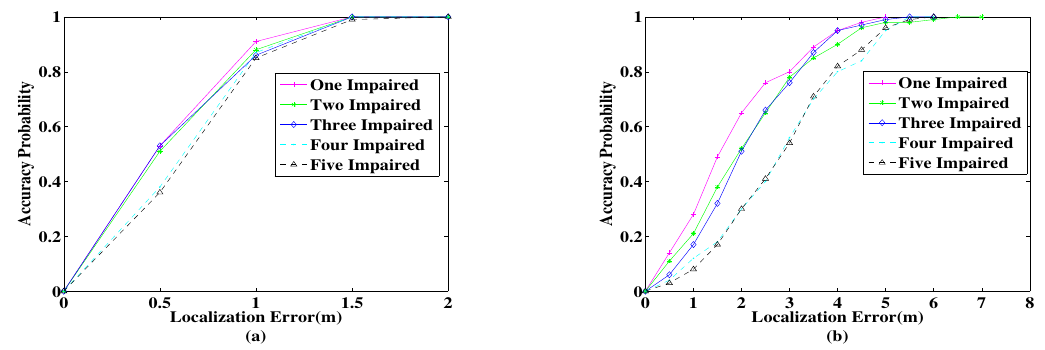
Figure 11. Error analysis of different numbers of impaired APs. ( a ) Error analysis of the proposed algorithm. ( b ) Error analysis of the traditional fingerprinting algorithm.